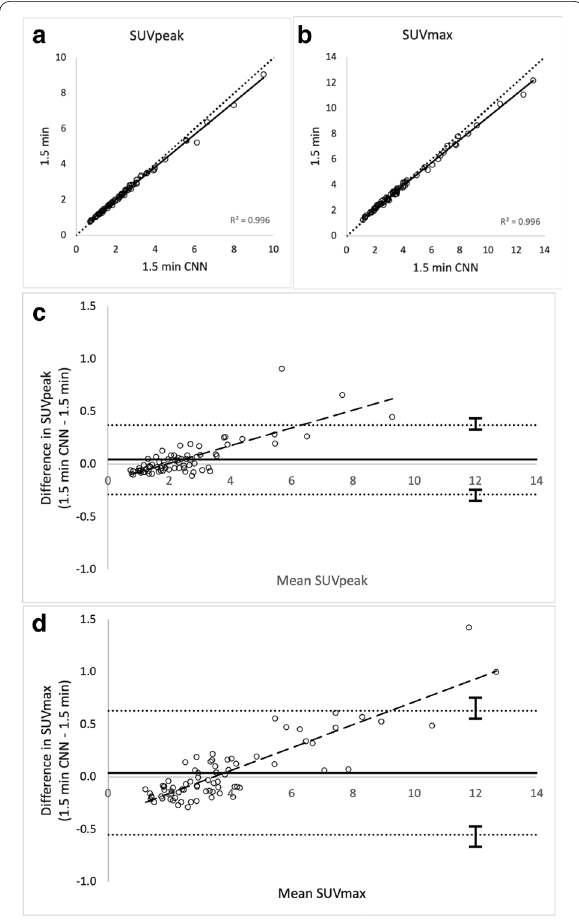
Fig. 4 Agreements and correlations between 1.0 min CNN–1.5 min image sets for SUV max , SUV peak . Pearson correlations ( a and b ). Bland– Altman plots ( c and d ). Mean of differences were ( respectively). 95% limits of agreement were (0.36 to to 0.97, − 0.29 and 0.63 − Qualitative analysis Reader 2 evaluated all image sets in the test group and found no added or subtracted hotspots in any image set. for each image set of each reader are presented in Table 4.